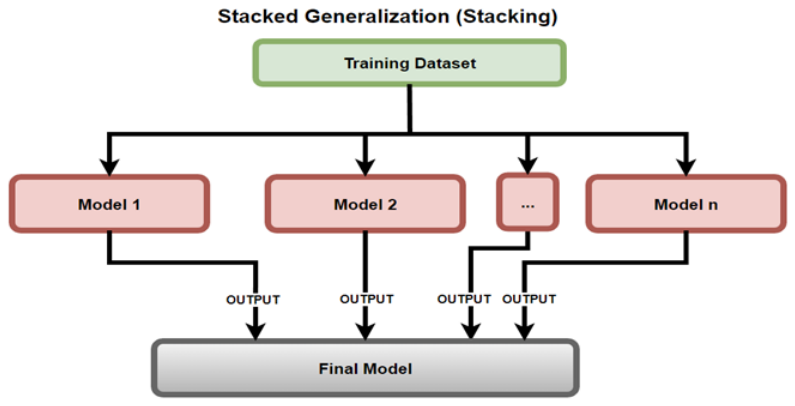
Figure 13. Stacked Generalization (Stacking).